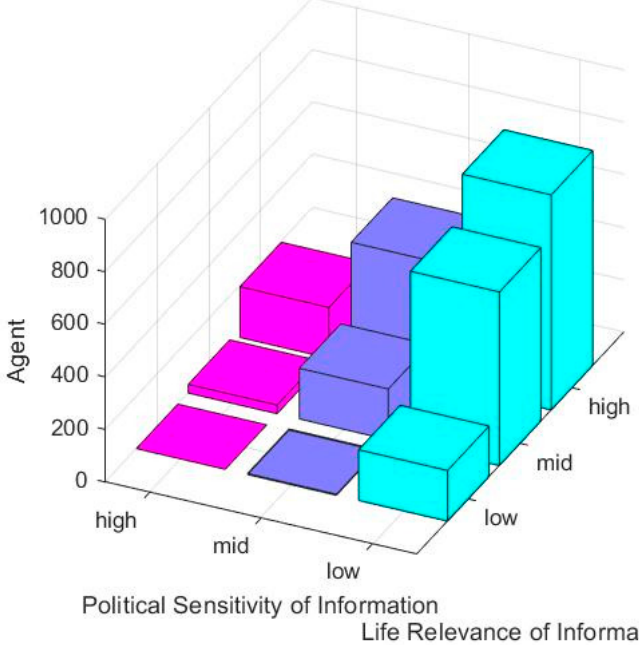
Figure 7. The number of people expressing their attitudes under different life relevance of information and political sensitivity of information.